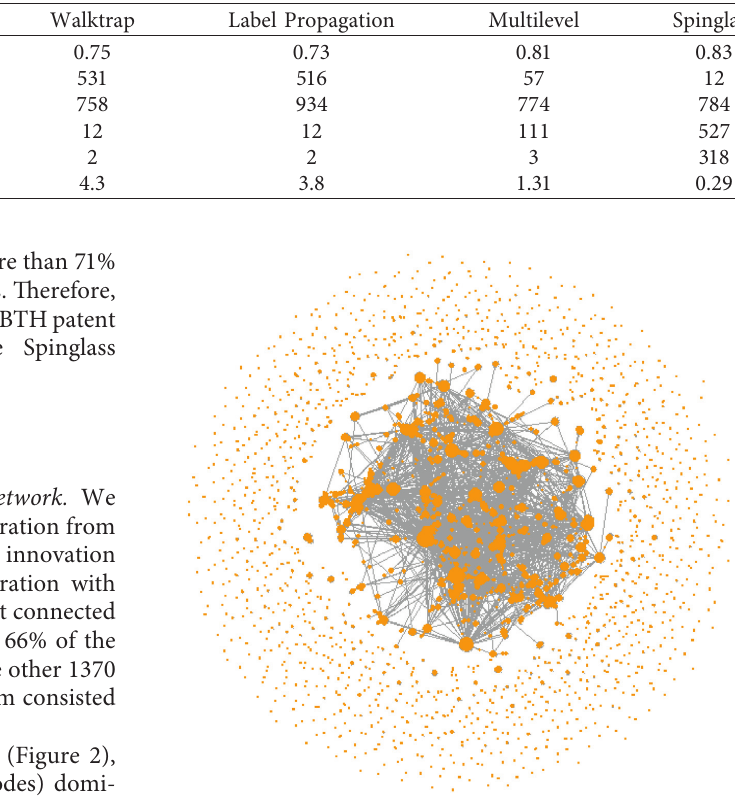
Table 1: Comparison of community detection algorithms in BTH patent cooperation network.